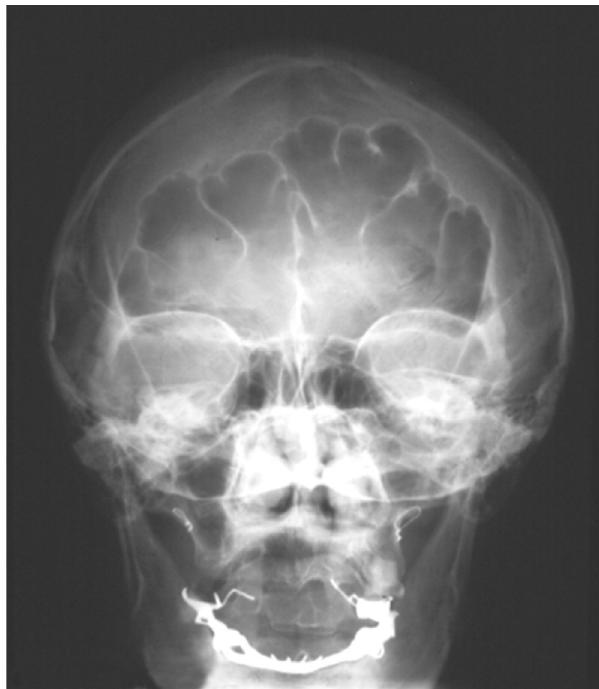
Figure 1 - Lateral skull radiographs showed significant frontal and occipital bossing, multiple wormian bones in the lambdoid suture associated with ill-defined skull base deformity and total loss of teeth.